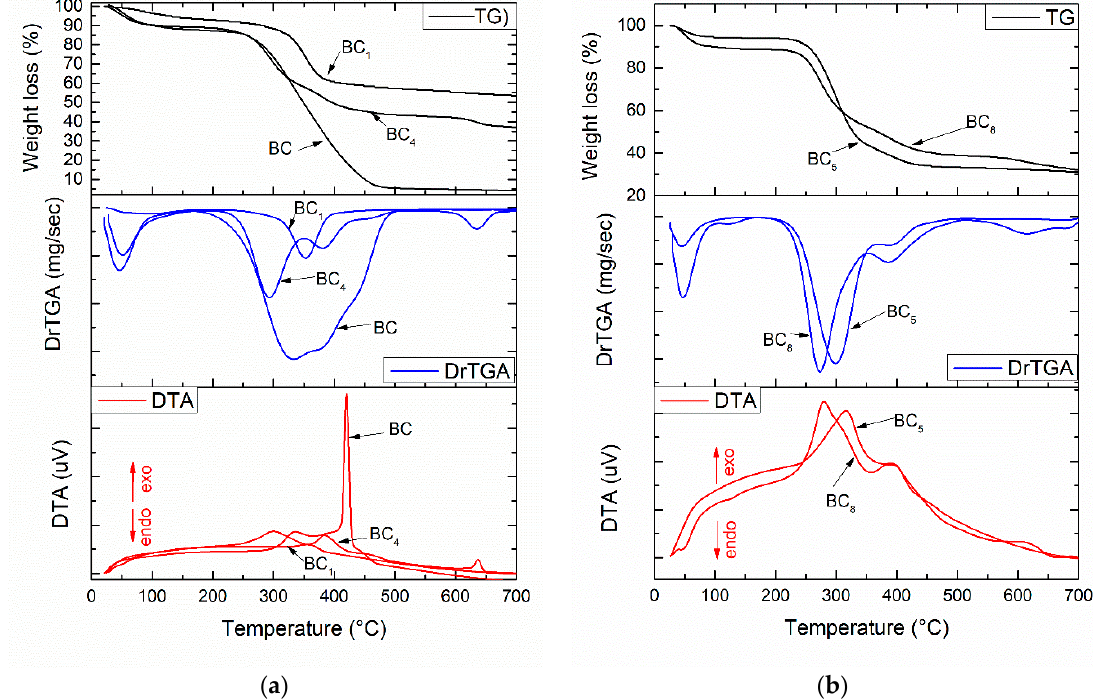
Figure 4. Thermal analysis corresponding to the composite samples: ( a ) BC 1 and BC 4 ; ( b ) BC 5 and BC 8.